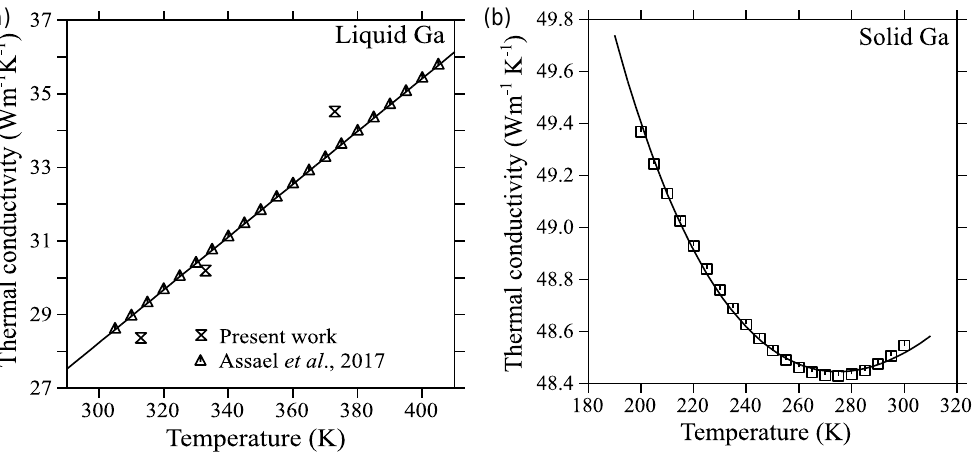
Figure 5. Comparison between calculated (solid line) and experimental (symbols) thermal conduc- tivities of pure Ga in ( a ) liquid (literature data from Assael et al. [14]) and ( b ) solid state.